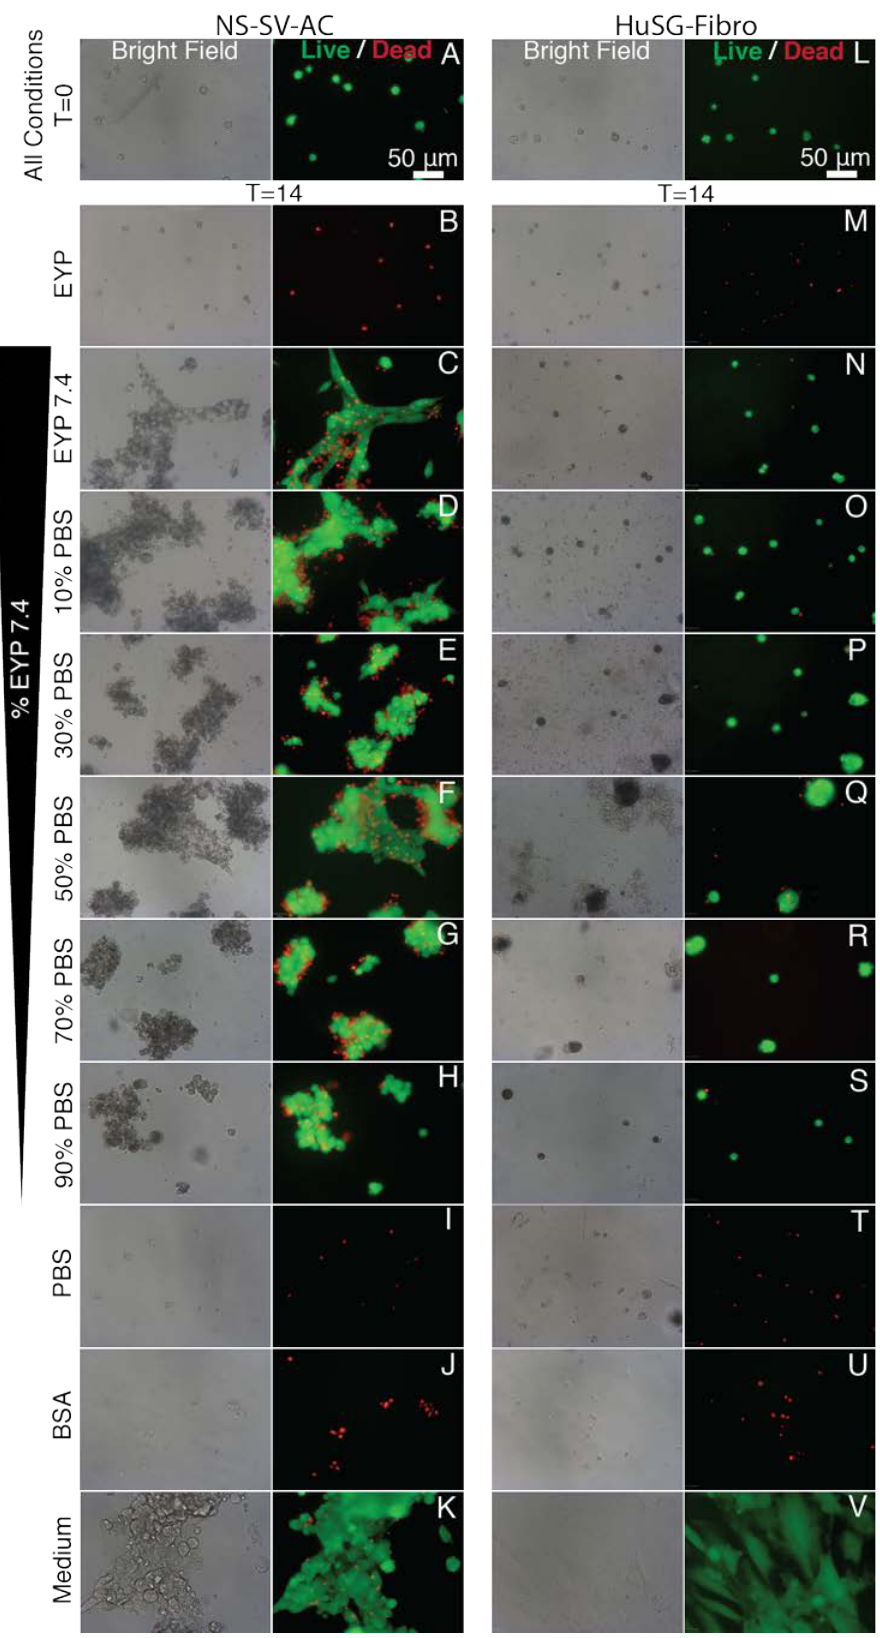
Figure A5. Bright Field and Fluorescent Images of NS-SV-AC and HuSG-Fibro Cells in EYP+NaOH (EYP 7.4) Cultured with Different Concentrations of PBS and Stained with Live/Dead. Representative images of the quantified data were taken inside the well of a 96-well plate with a 20X objective (For the quantified data see Figure 4).